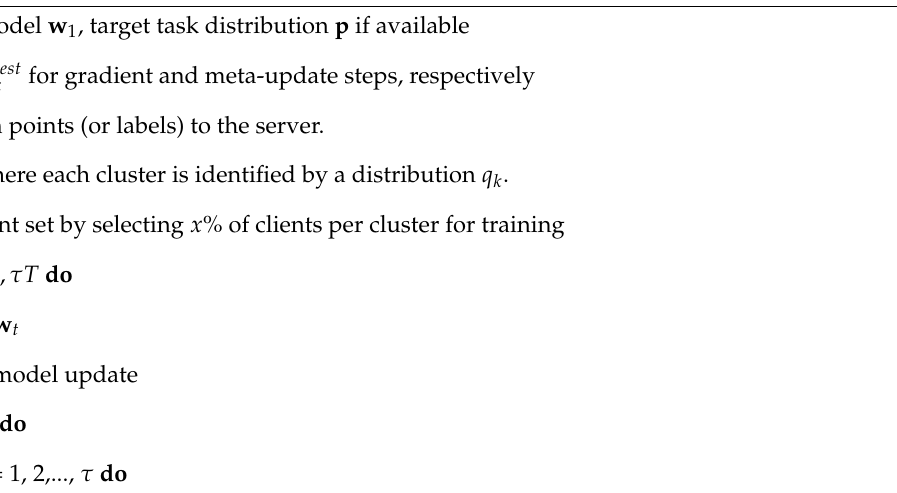
Algorithm 1 Federated meta-learning with clustering. S: MECserver, C: